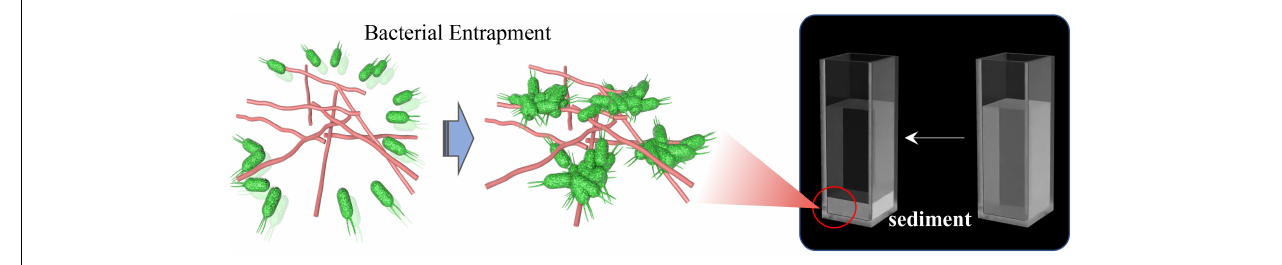
FIGURE 10 | The phenomenon of bacterial entrapment caused by AMP-SAP in vitro (Li et al., 2021). Copyright 2021 by the BioMed